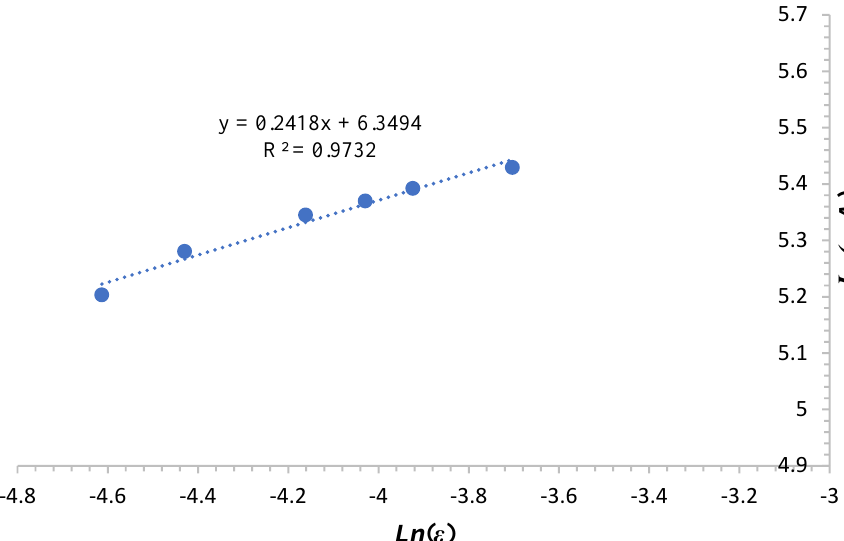
Figure 10. Fitting curve ln (σ − A) in function of ln(ε) .